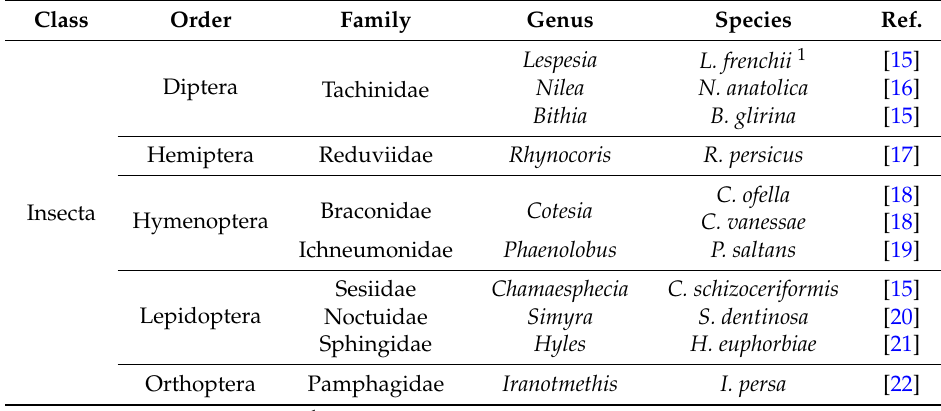
Table 6. List of insects in the Western part of National Park of Urmia Lake.